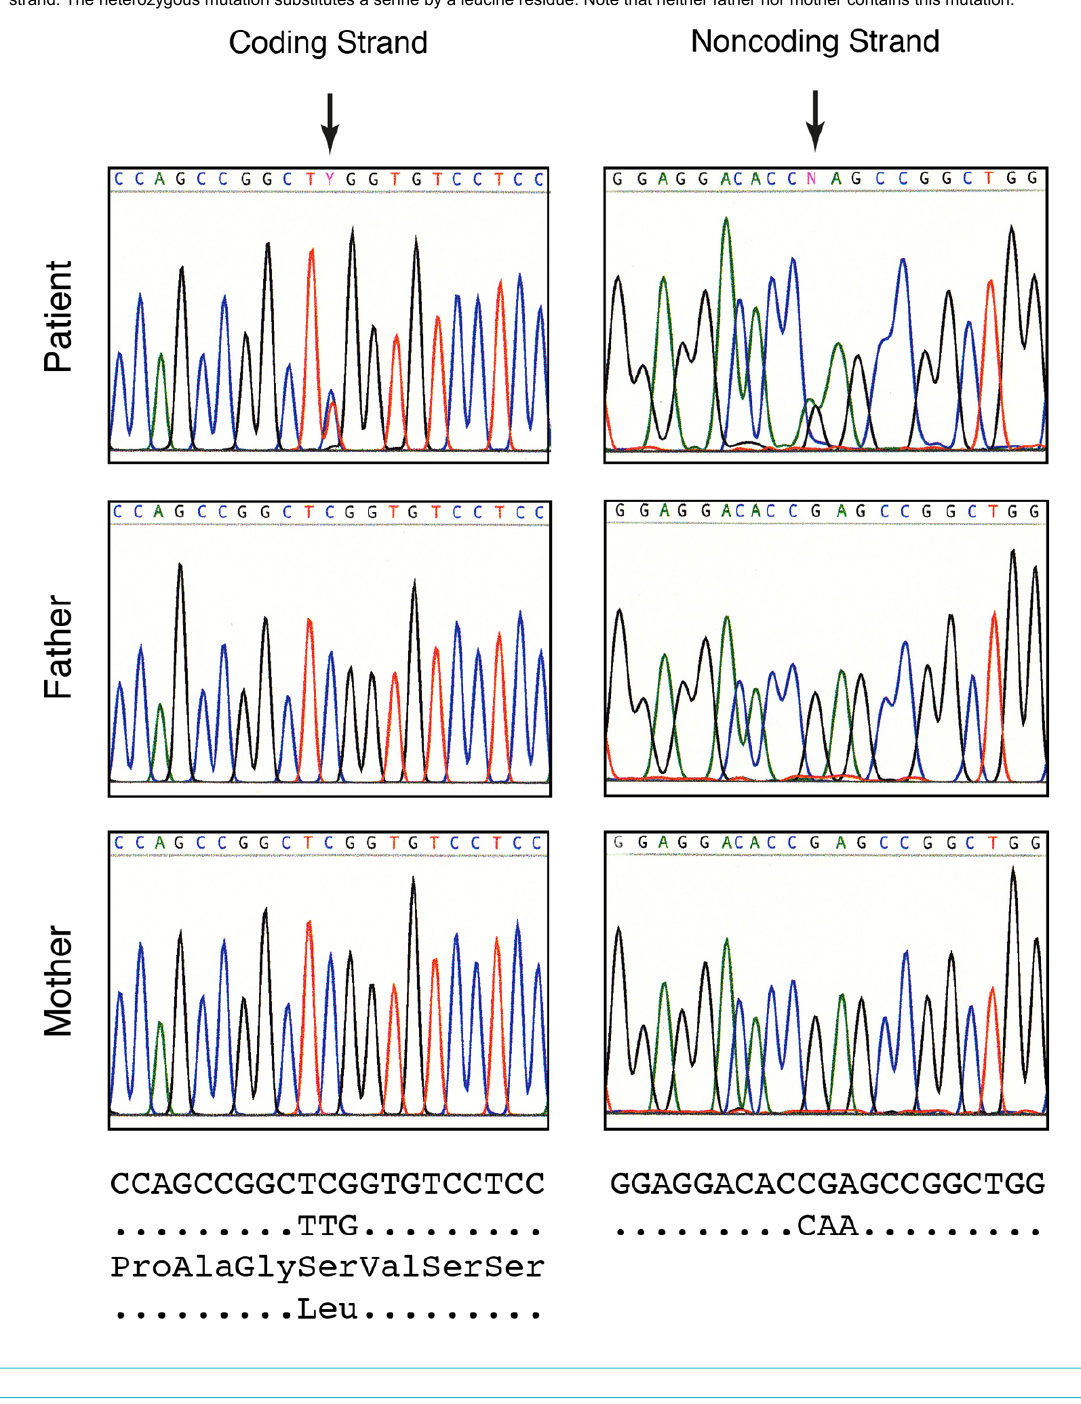
Figure 3: Sequencing of the MAFB gene. Parts of the original sequencing chromatograms are shown together with the genomic DNA se- quence and the predicted amino acid sequence. The patient reveals a C>T transition that is found on the coding as well as on the noncoding